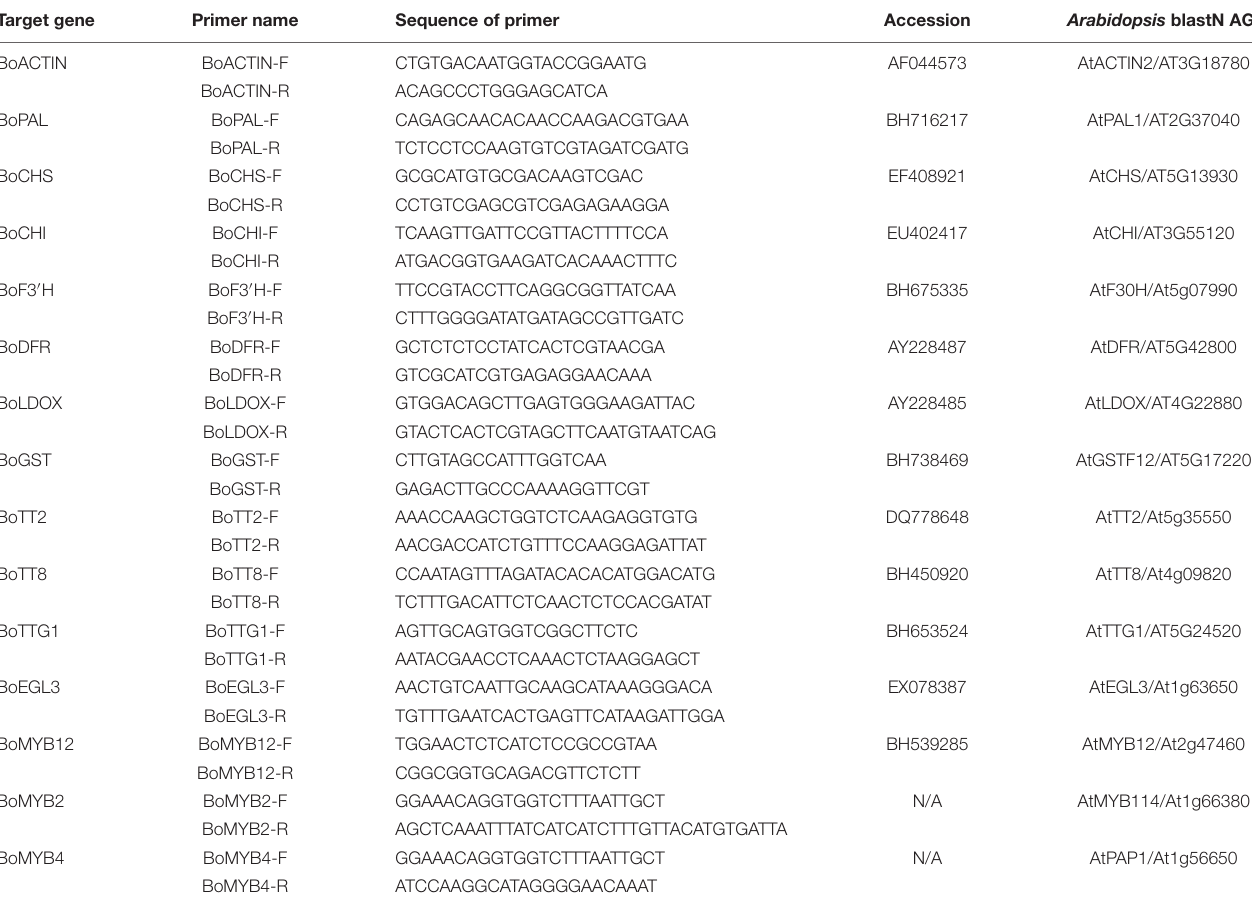
TABLE 1 | Oligonucleotide primers used for qRT-PCR